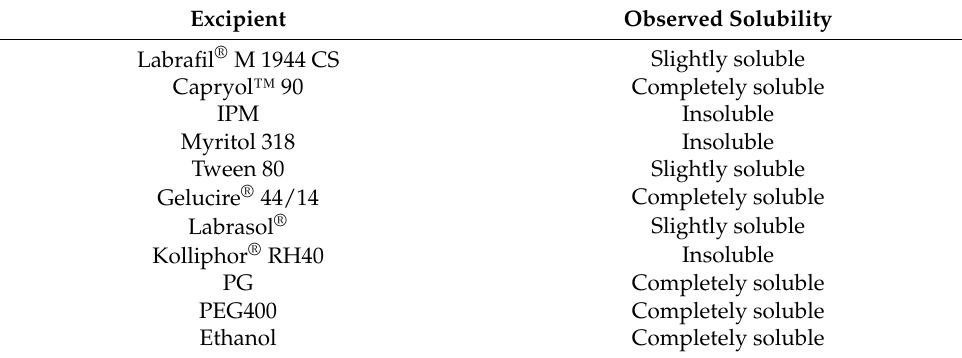
Figure 2. Analytical HPLC-UV chromatograms of frankincense extract at ( A ) 210 nm and ( B ) 260 nm. Table 2. Solubility study observations of frankincense extract in different oils, surfactants (10% solutions), and